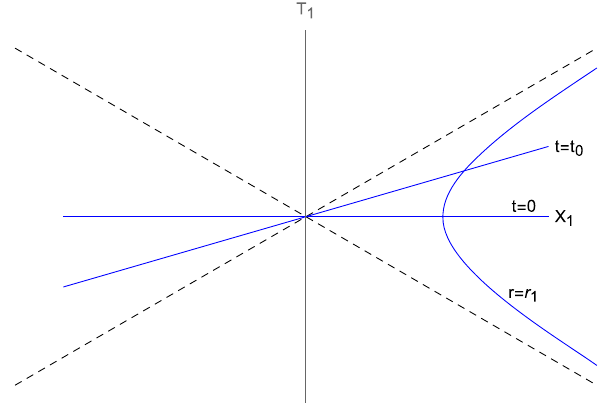
Fig. 1 Kruskal spacetime and the ( t , r ) foliation of it